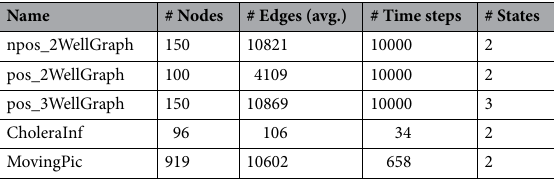
Table 1. Statistics of each dataset used in this